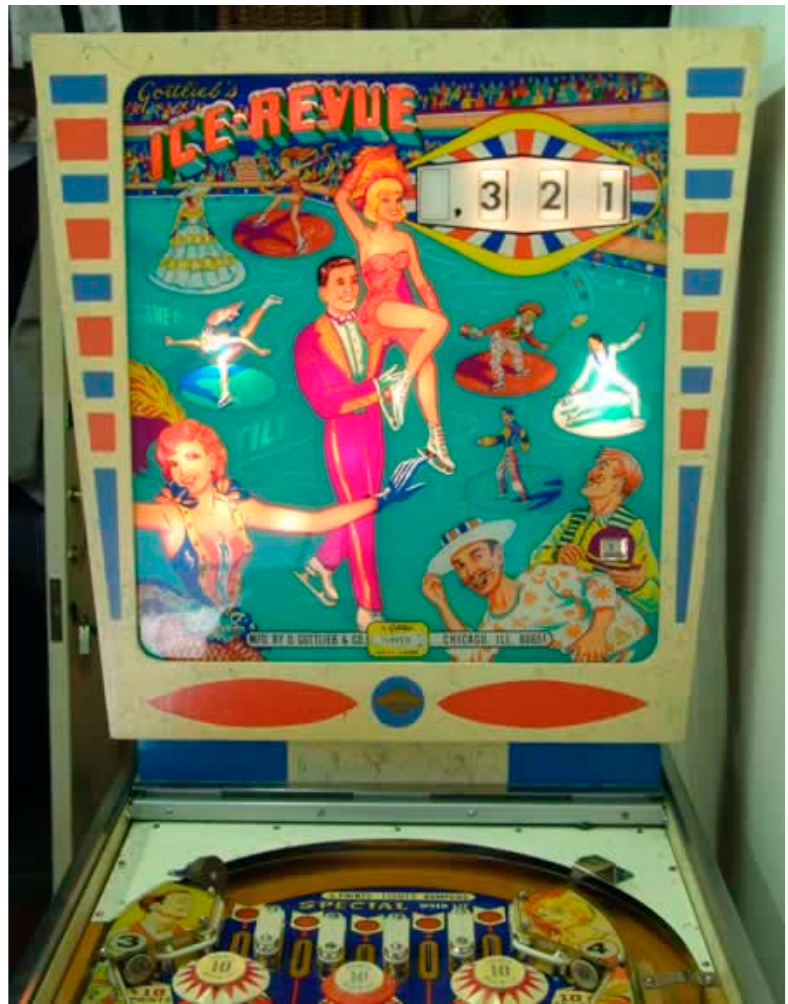
Figure 2. A backglass image (Ice Revue, released by Gottlieb in 1965), representing urban culture in an indoor-sports environment; used with permission © Ros-vintagepinballs.co.uk.